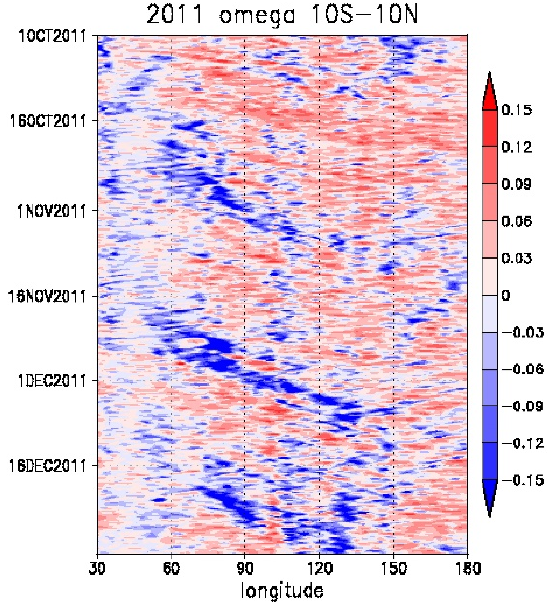
Figure 1. The longitude and time diagram of vertical velocity (in Pa·s − 1 ) averaged in latitude between 10 ° N and 10 ° S from 0000 UTC 1 October 2011 to 1800 UTC 31 December 2011. The longitudinal range is from 30 ° E to 180 ° E.